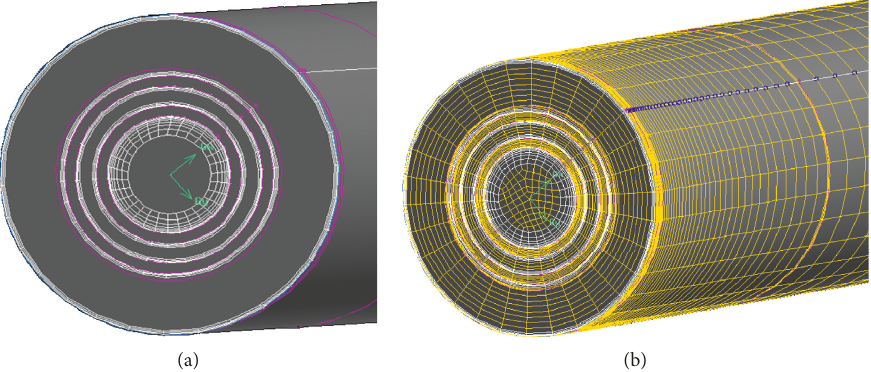
Figure 3: Mesh distribution: (a) the boundary layer mesh distribution, (b) the hexahedral mesh distribution. Table 2: The values of the three parameters. Parameters